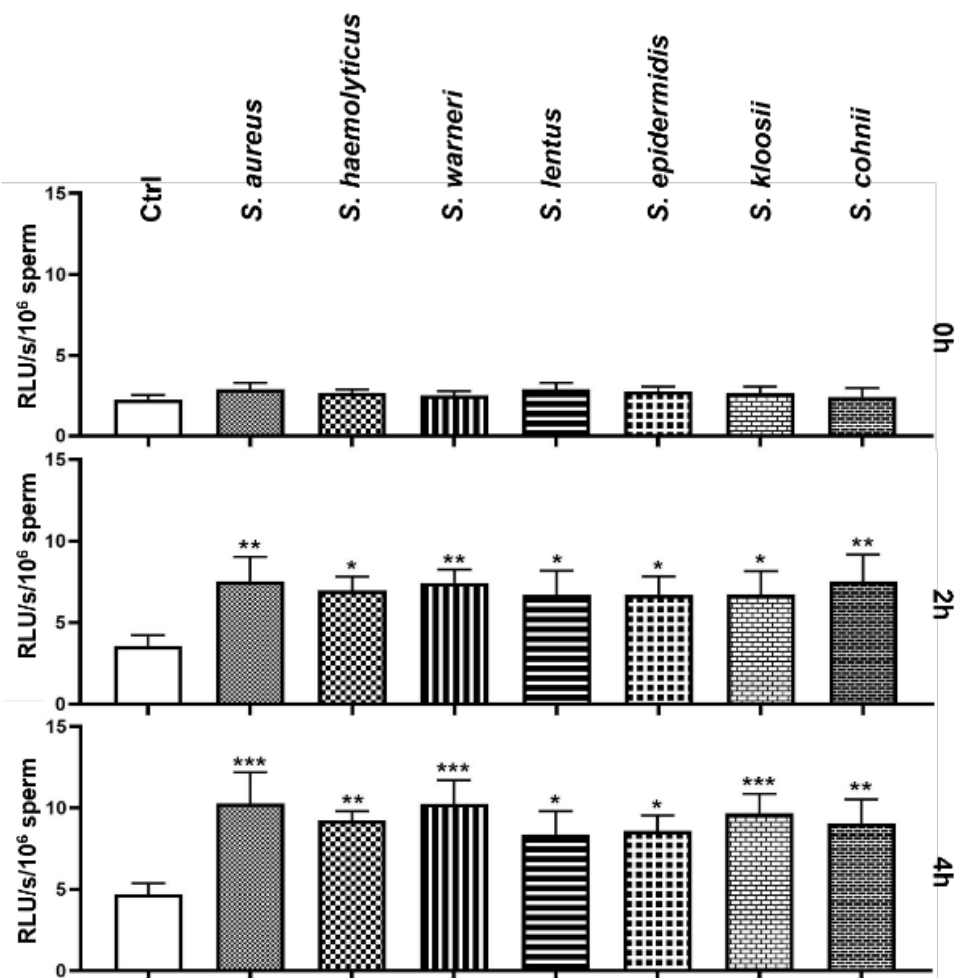
Figure 4. Changes in the global reactive oxygen species production during the 4 h bacteria/sperm co-incubation in vitro at 37 °C. Each group treated with Staphylococcus species was compared with the Ctrl group with no added bacteria. Each bar represents the mean value of relative light units per second per 10 6 sperm cells ± S.E.M. Five individual experiments were performed to obtain these data. The level of statistical significance was set at * p < 0.05; ** p < 0.01; *** p < 0.001.